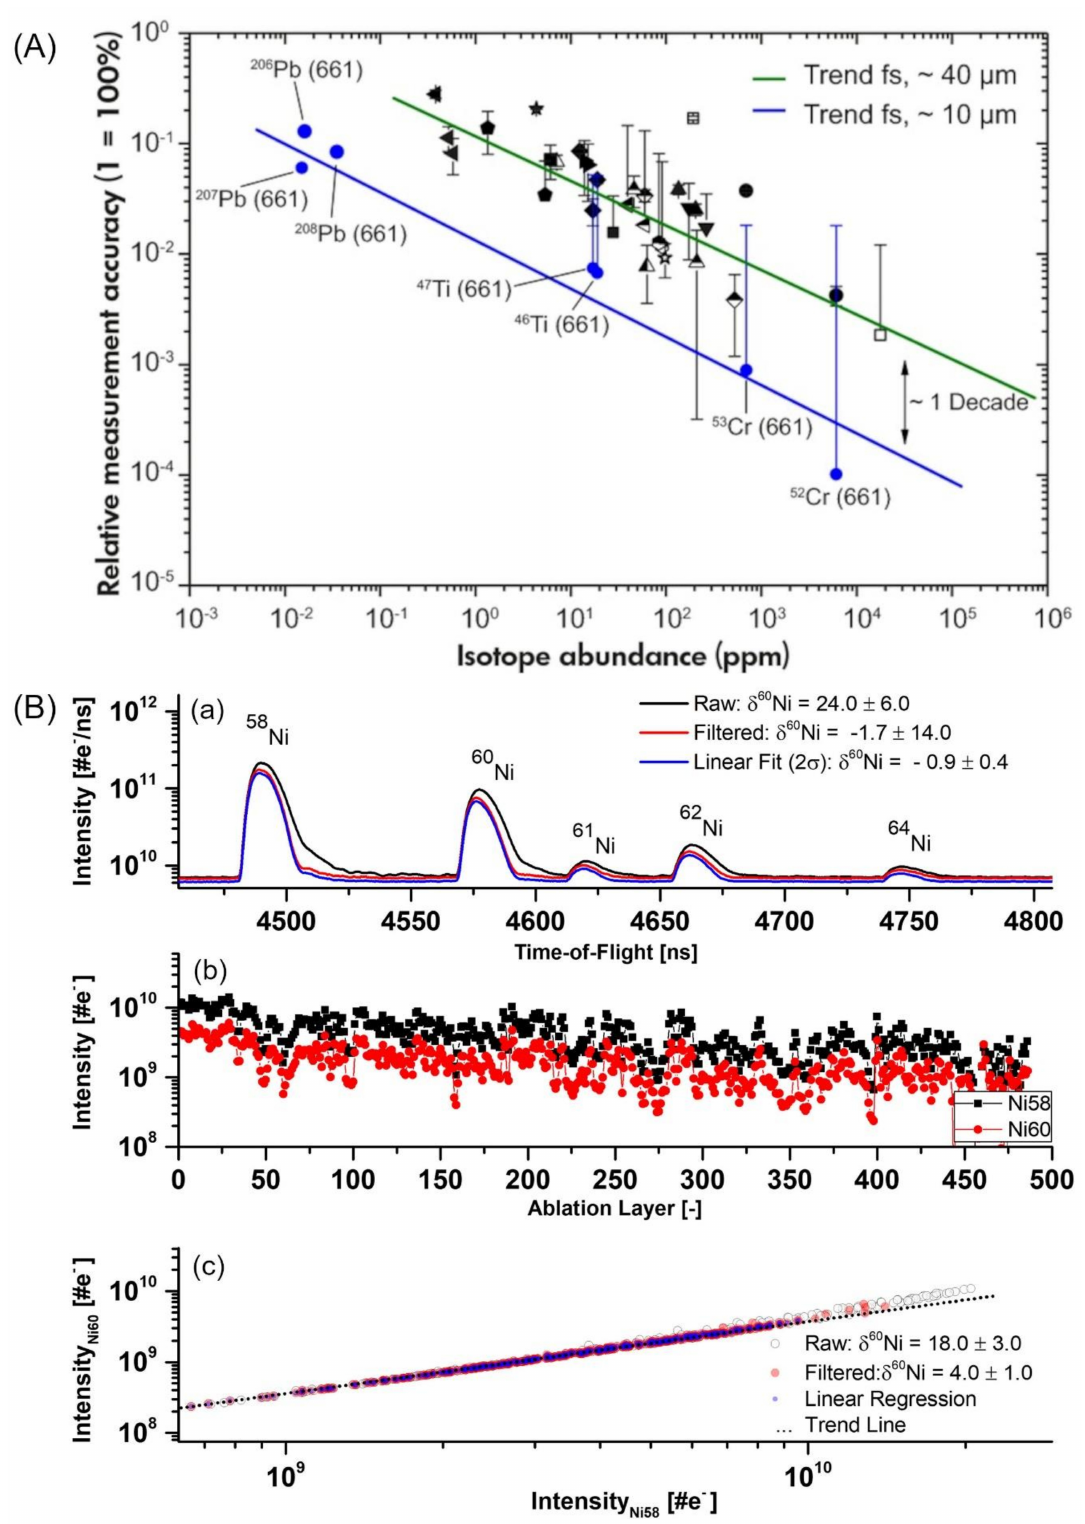
Figure 9. ( A ) Correlation between relative measurement accuracy of isotope ratios and isotope abundance determined from the mass spectra of the NIST SRM 661 steel sample measured by IR fs-LMS. Black and blue points indicate the measurements with laser ablation optics focusing to spot 40 µ m and 10 µ m, respectively; [27] ( B ) Isotope analysis of NIST SRM 658 Ni isotope standard sample showing the composite mass spectrum of Ni isotopes ( a ); depth profile built on 58 Ni and 60 Ni isotopes ( b ) and the intensity correlation curve ( c ). After filtering of the depth profile data, the accuracy and precision from 1% down to 1 per mill level can be achieved [152]. Reprinted with permission